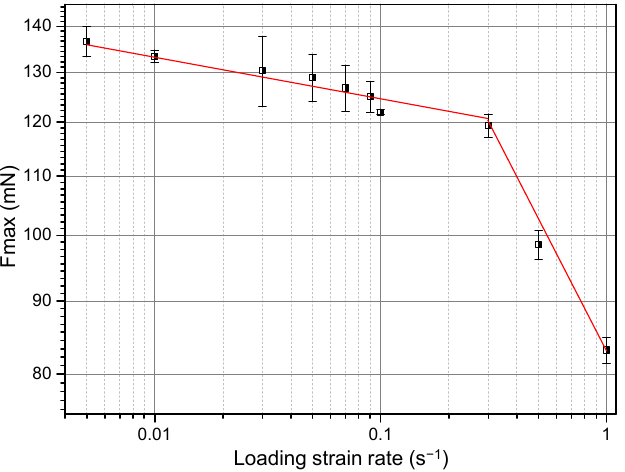
Figure 5. Relationship between maximum holding loads F max and loading strain rates of the RS NC Mg–Gd–Y–Zr alloy.